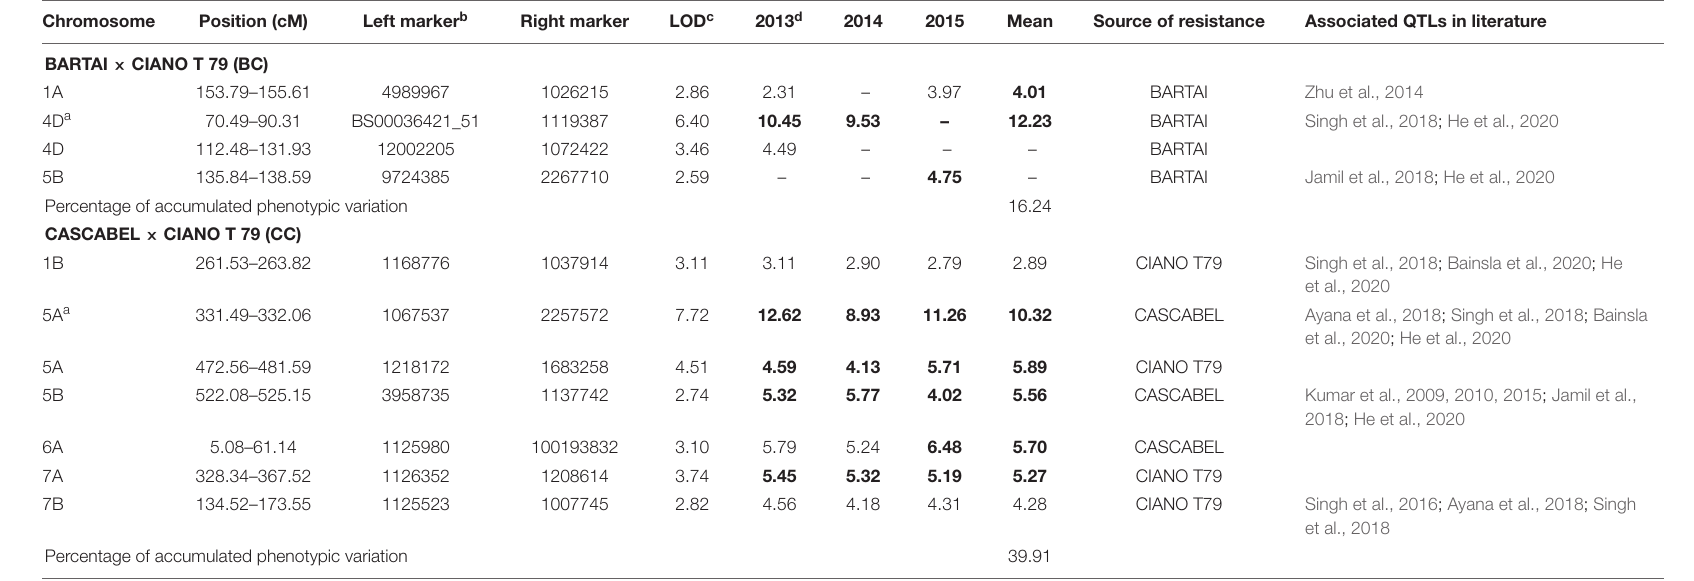
TABLE 3 | Quantitative trait loci (QTLs) identified for SB in the BARTAI × CIANO T79 (BC) and CASCABEL × CIANO T79 (CC) populations and their associated QTLs in literature. Chromosome Position (cM) Left marker b Right marker LOD